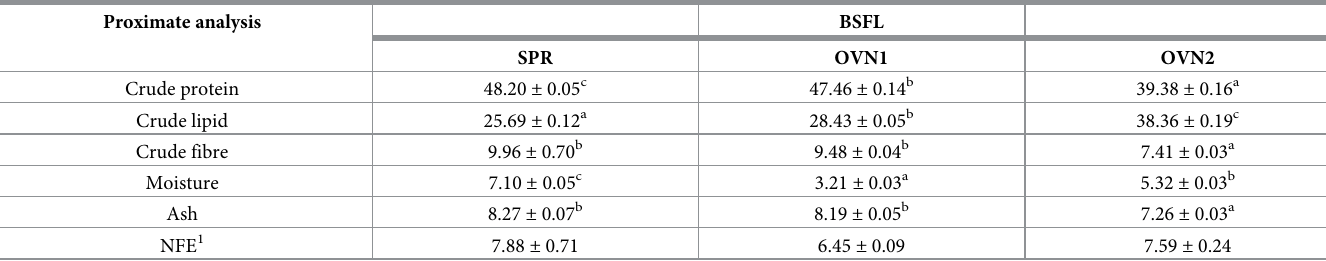
Table 1. Proximate composition of the BSFL (% DM). Proximate analysis